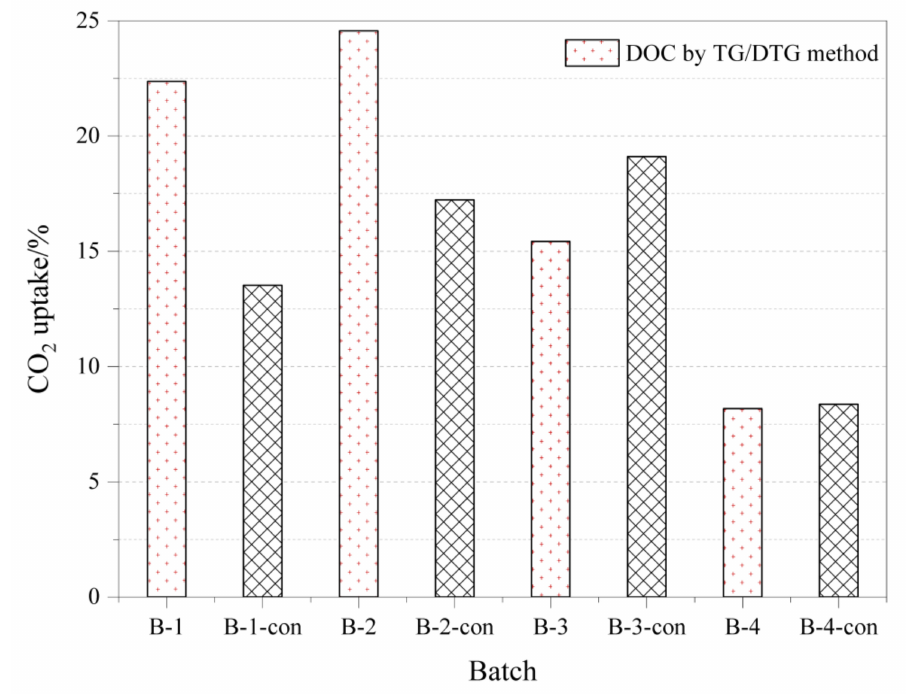
Figure 4. CO 2 uptake by TG-DTG